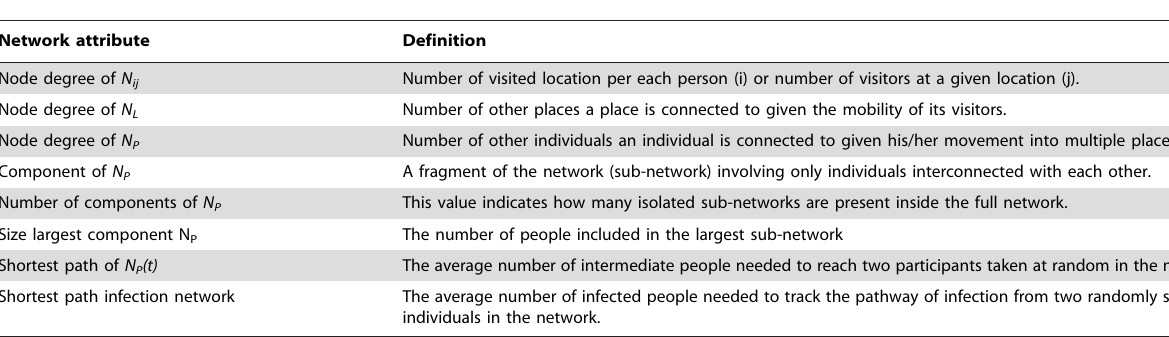
Table 1. Glossary of network topology terms used in the